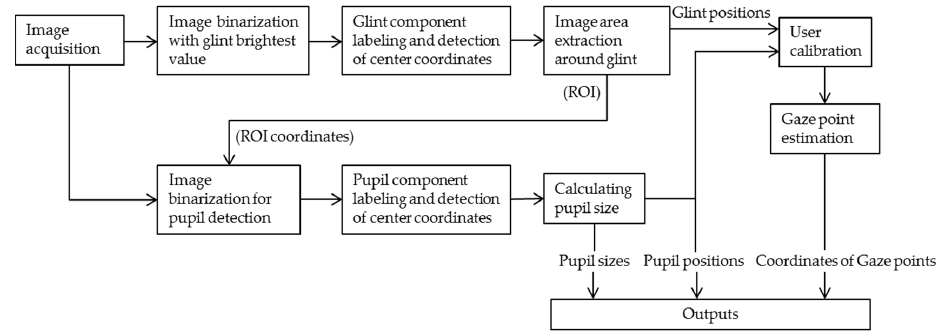
Figure 5. Flow chart of eye gaze tracking system. region of interest (ROI): region of interest.